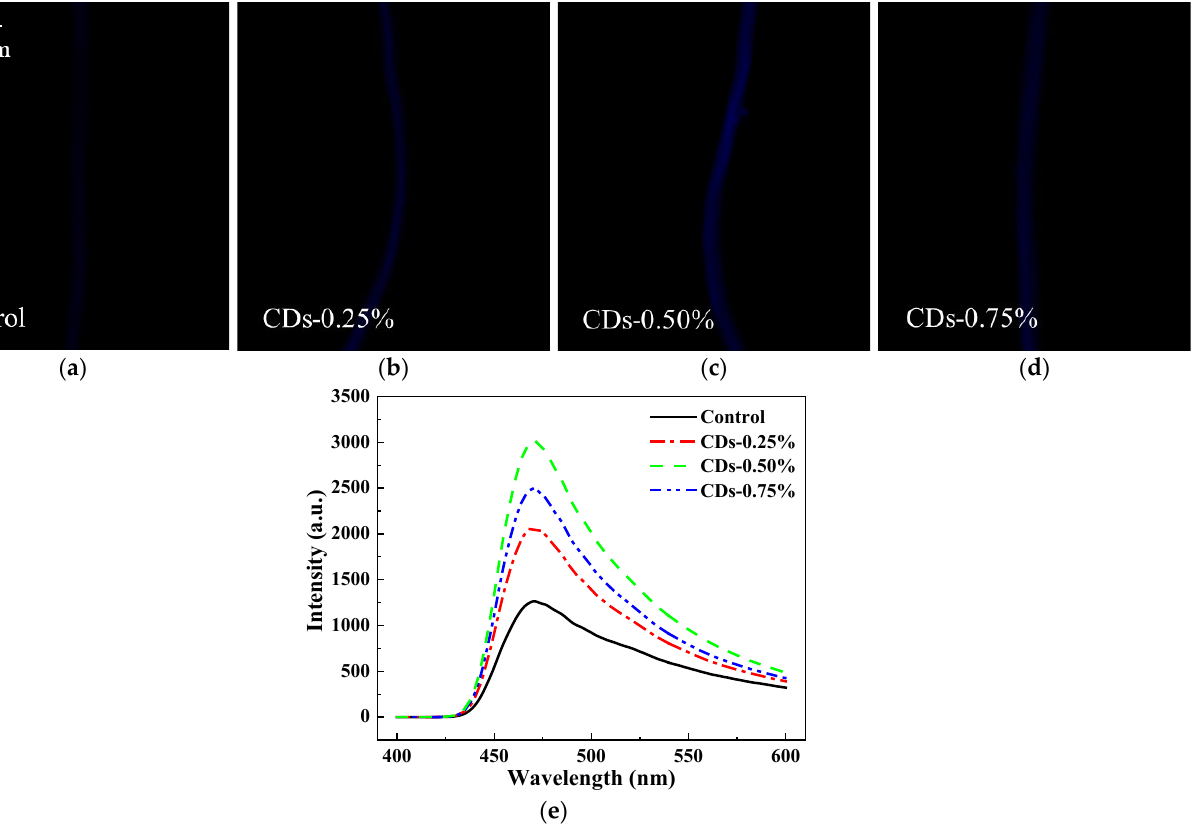
Figure 7. SEM images of silk fibroin fiber: ( a ) control, ( b ) CDs-0.25%, ( c ) CDs-0.50% and ( d ) CDs-0.75%. Figure 8. Effect of CDs on the fluorescent intensity of silk fibroin fiber. ( a – d ) Confocal laser mi- croscopy images of silk fibroin fiber (measured with an excitation wavelength of 405 nm); ( e ) PL spectra of silk fibroin fiber (measured with an excitation wavelength of 370 nm).